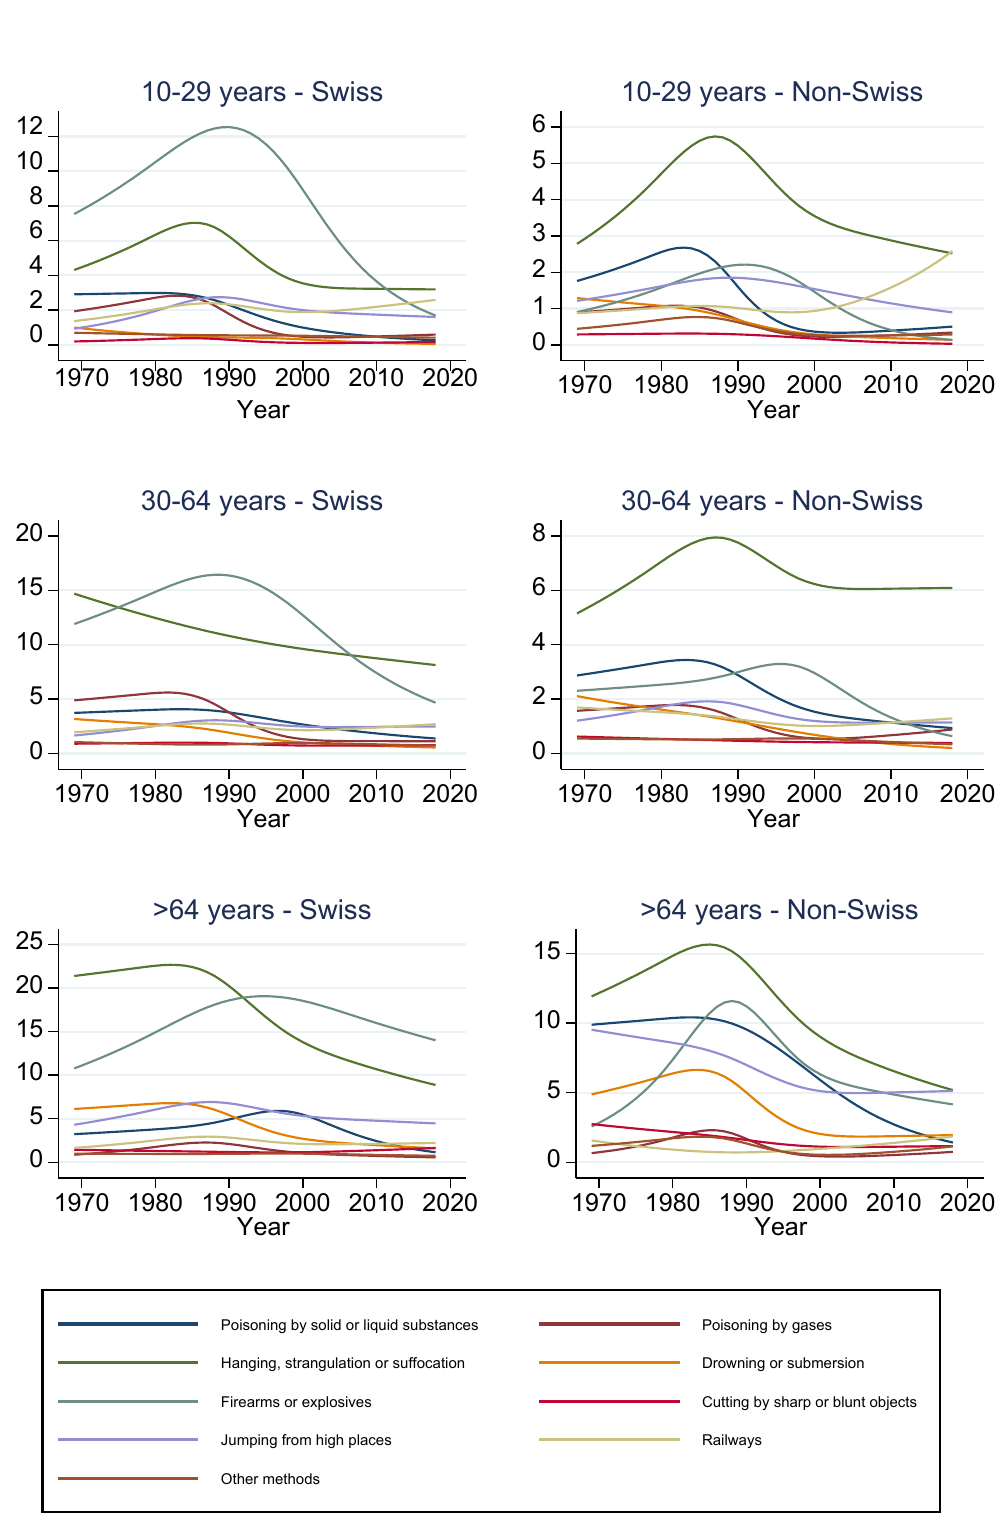
Figure S1. Rates of suicide methods per 100'000 population (person-years) in men.